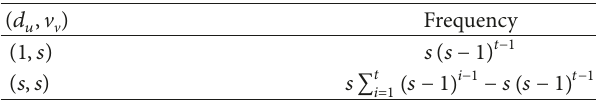
Table 3: Edge partition of 𝐶 𝑠,𝑡 based on degrees of end vertices of each